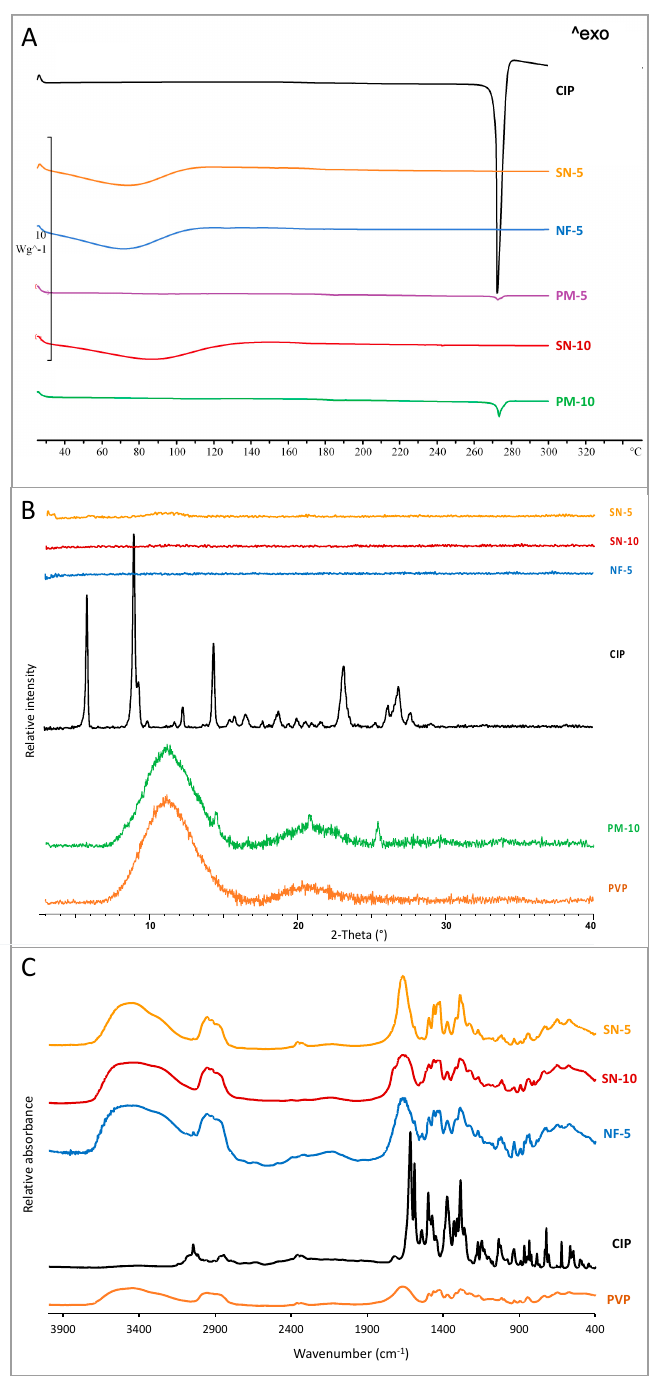
Figure 4. Physicochemical properties of ciprofloxacin-loaded PVP nanofibers. DSC thermograms ( A ) and XRPD diffractograms ( B ) proved that the amorphous state of the drug in the nanofibers produced both single-nozzle (SN-5 and SN-10) and nozzle-free (NF-5) electrospinning. As references, pure ciprofloxacin powder (CIP) and physical mixture (PM) were used. The successful incorporation of the drug was confirmed with FTIR spectra ( C ). The characteristic shifts and widenings showed up at the same wavenumbers, demonstrating successful incorporation in all cases, regardless of the ES